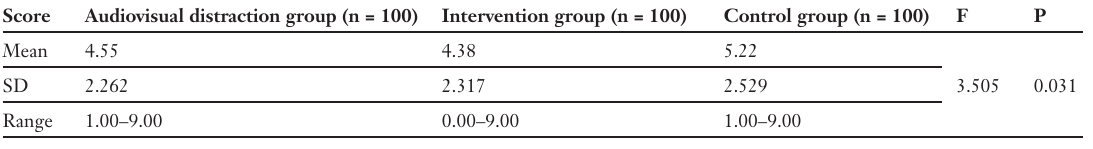
Multiple comparisons of VAS scores in the three